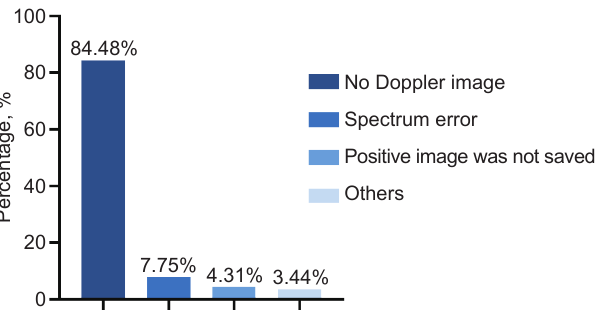
Figure 2 The common errors in image scoring from 2014 to 2018.